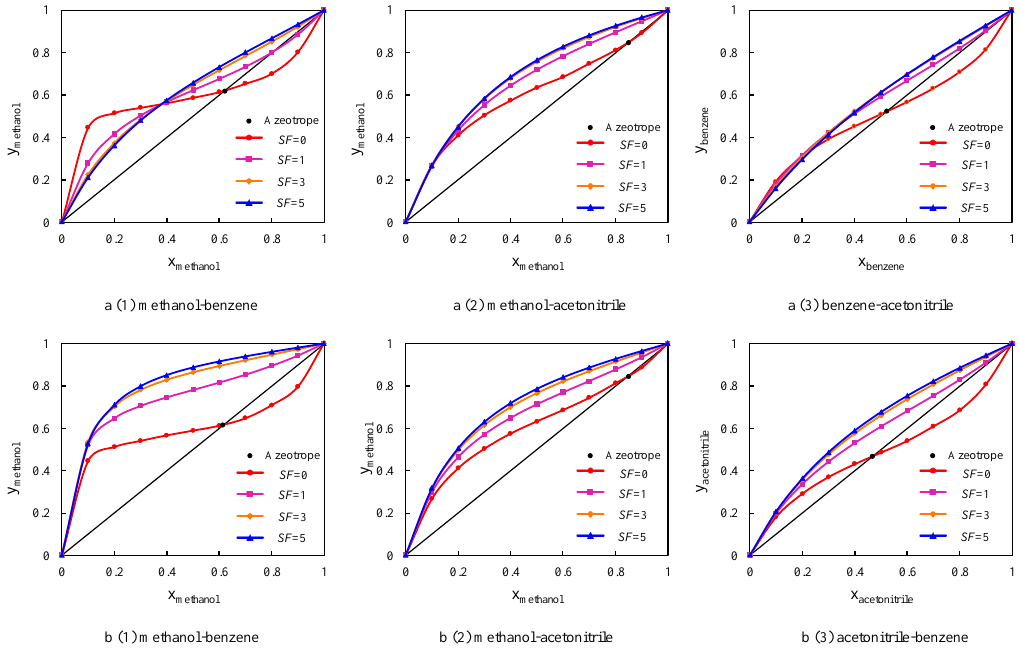
Figure 2. Vapor – liquid equilibrium curves with solvent AN ( a ) and CB ( b ) added. Figure 2. Vapor–liquid equilibrium curves with solvent AN ( a ) and CB ( b ) added.